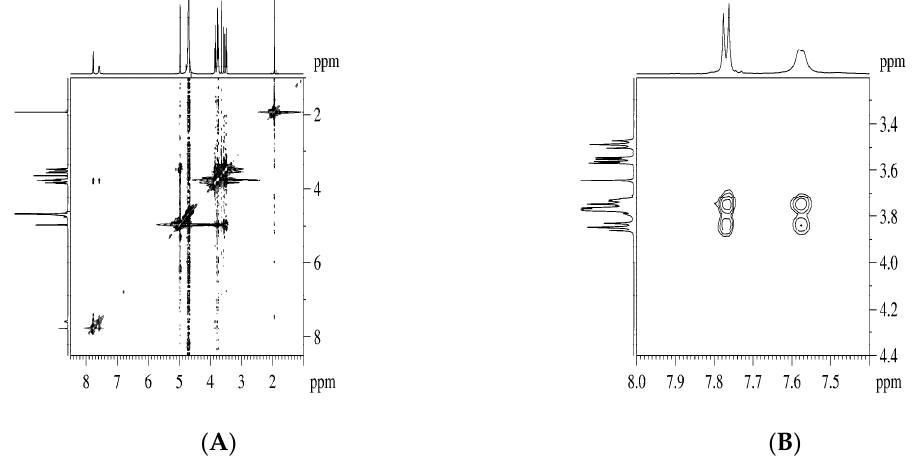
Figure 9. ( A ) The ROESY spectrum of DA: β CD (1:1) inclusion complex, recorded in D 2 O, with suppression of the water signal; ( B ) Expansion of the ROESY spectrum showing the NOE cross-peaks between phenyl protons of DA and internal β CD protons (H-3, H-5).